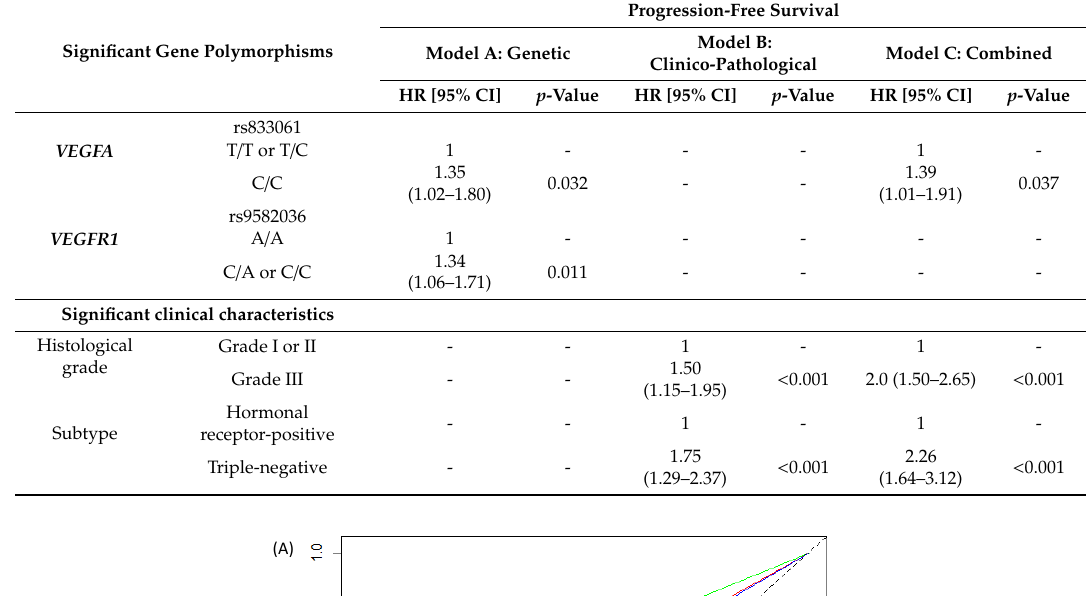
Table 3. Multivariate analysis according to PFS.